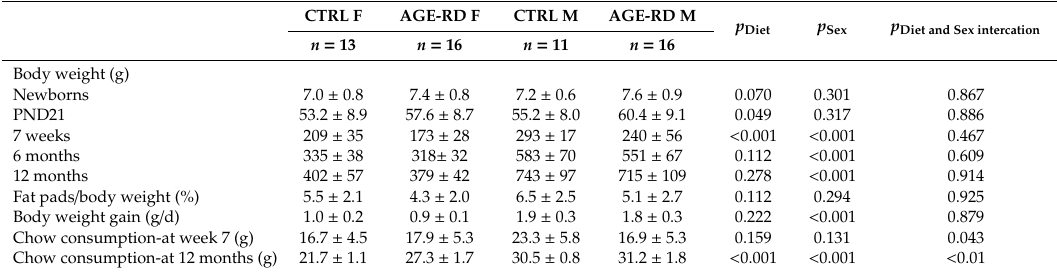
Table 1. F1 o ff spring: Body weight and chow